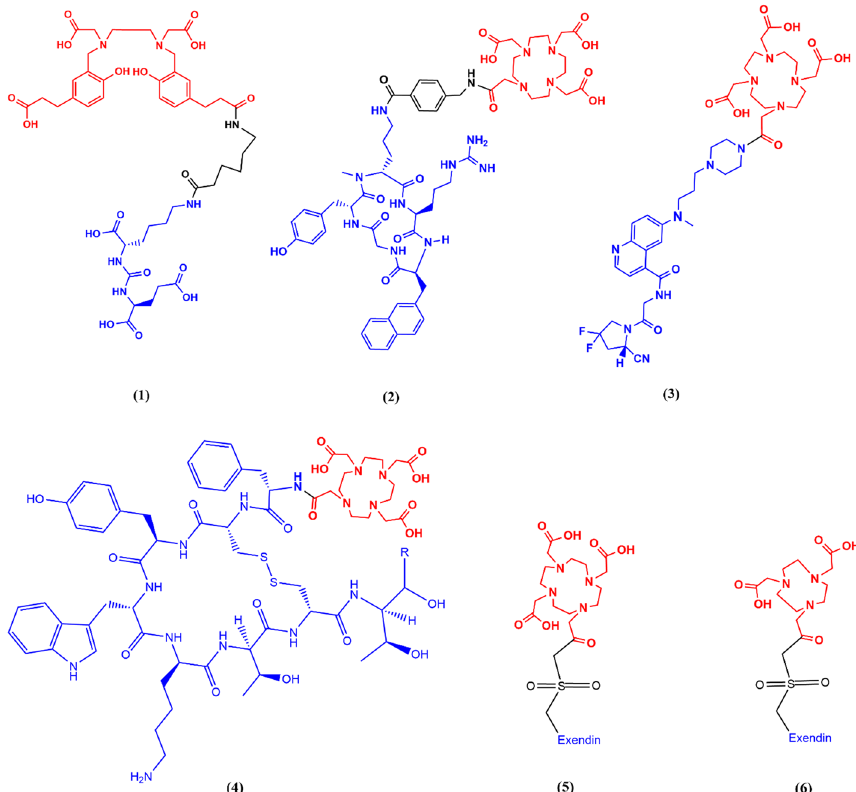
Fig. 1 Structures of several 68 Ga radiopharmaceuticals in clinical use ( 1 ) PSMA-11 (Fuscaldi et al.2021; Hennrich and Eder 2021) ( 2 ) PentixaFor (Sammartano et al. 2020; Spreckelmeyer et al. 2020) ( 3 ) FAPI-46 (Spreckelmeyer et al. 2020) ( 4 ) R H DOTA-TOC (Bauwens et al. 2010; Decristoforo et al. 2007); R = DOTA-TATE ( 5 ) Exendin peptide sequence HGEGTFTSDL SKQ M EEEAVR LFIEWLKNGG PSSGAPPPS = C Exendin-4-Cys40(DOTA) (Velikyan et al. 2017) ( 6 ) Exendin peptide sequence = EEEAVR LFIEWLKNGG PSSGAPPPS K Exendin-4-Lys40(NODAGA) (Velikyan et al. 2017; Migliari et al. =